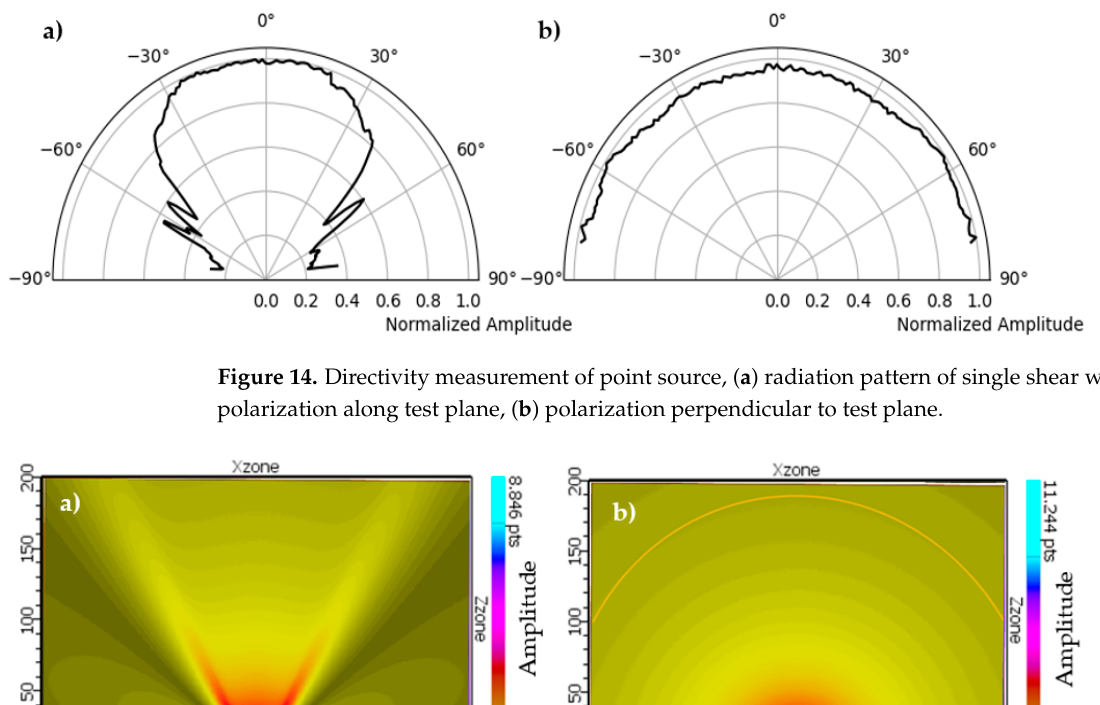
Figure 16. ( a ) Comparison of calculation, simulation, and measurement of radiation pattern of shear horizontal wave, polarization along the test plane, ( b ) polarization perpendicular to the test plane. 3.2. Validation of Second Generation Borehole Probe A similar measurement is carried out with the second generation borehole probe on a polyamide test specimen to validate the phased array technique. The borehole probe was constructed with an SH-wave transducer with polarization perpendicular to the array axis, transmitting spherical waves. The second generation borehole probe shown in Figure 3 is attached to the flat bottom of the test specimen and serves as the transmitter. A multi- channel transmitter is used to apply delay time that directs the beam at specific angles inside the specimen. An example of a 45° beam shown in Figure 17 is the borehole probe directivity measurement and simulation radiation pattern. The signal is measured along the circular axis from 10° to 170° in steps of 1°. The maximum amplitude of each measure- ment signal (from 10° to 170°) is plotted in polar coordinates. A corresponding simulation is performed on the polyamide test specimen with a borehole probe. An eight-element